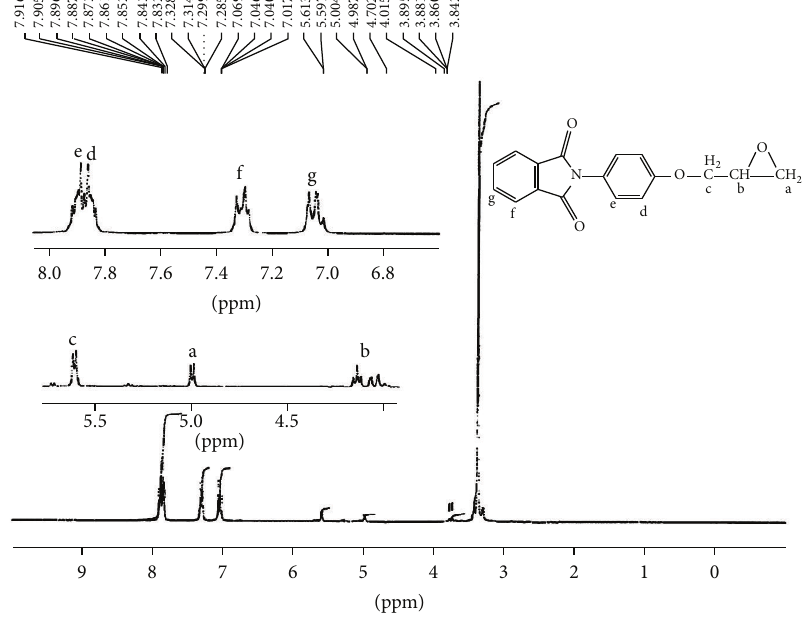
Figure 2: 1 H NMR for PPGE.